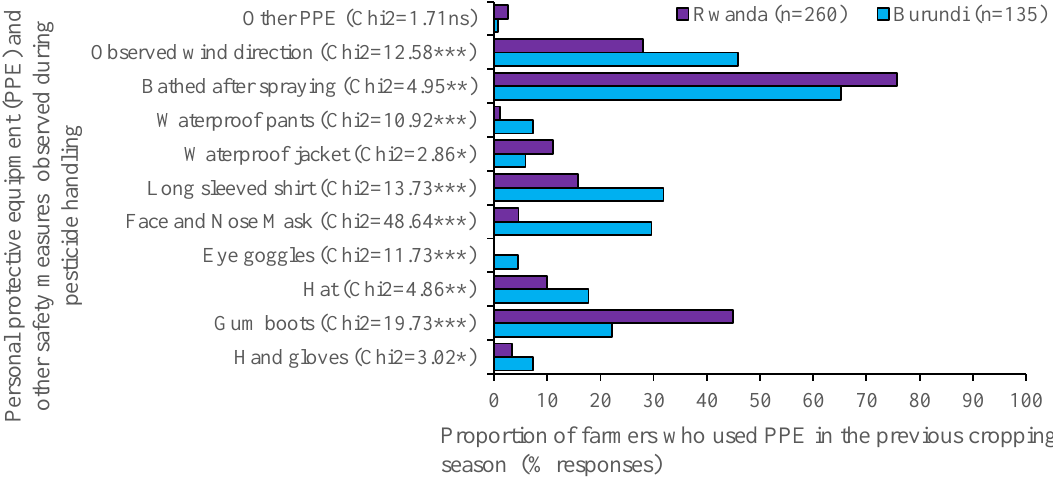
Figure 6. Use of personal protective equipment and other safety measures during pesticide handling by potato farmers in Rwanda and Burundi. ***, **, and * indicate statistical significance at p ≤ 0.01, p ≤ 0.05, and p ≤ 0.1, respectively. ns: not statistically different at p ≤ 0.1.